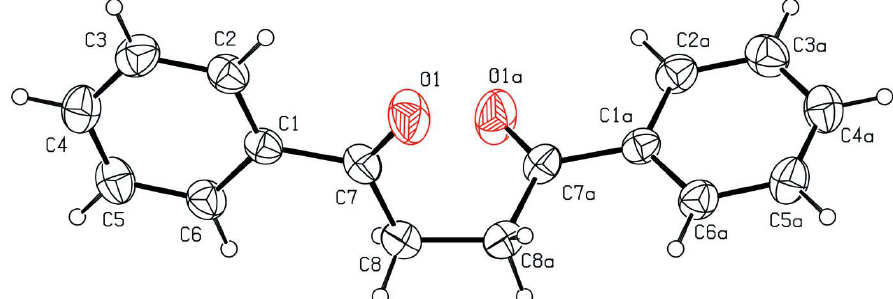
View of the title molecule showing the atom-labelling scheme. The displacement ellipsoids are drawn at the 30% probability level [symmetry code: ( a ) - x , - y + 1, z